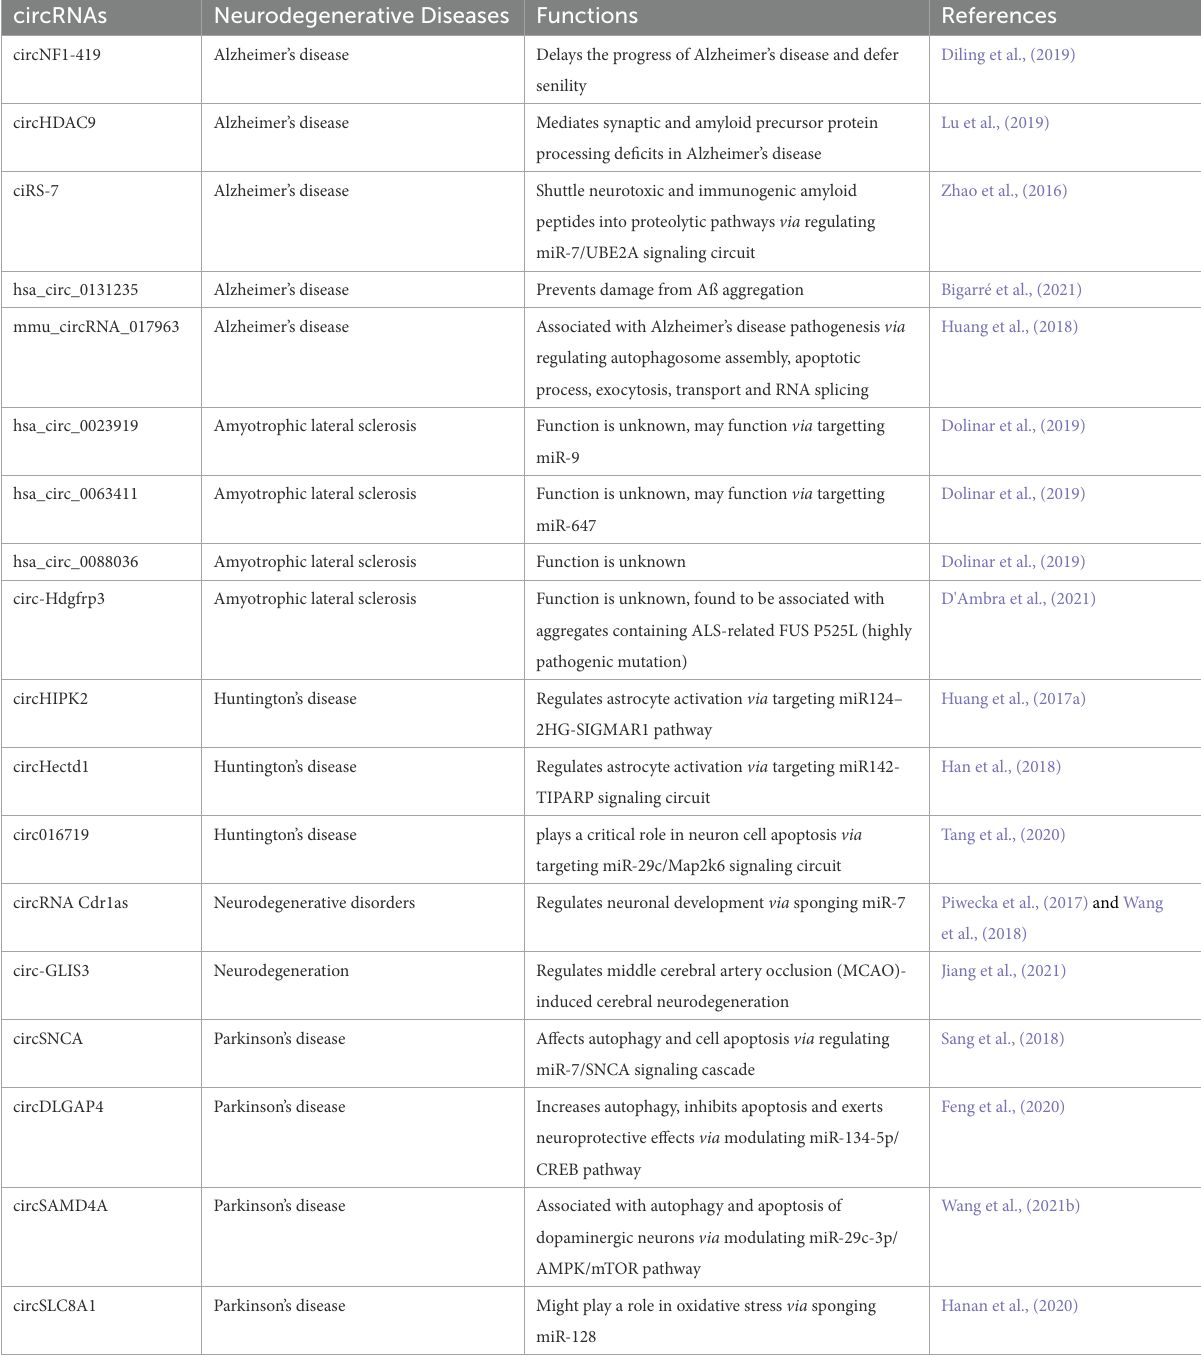
TABLE 1 List of circRNAs reported to be associated with autophagy and